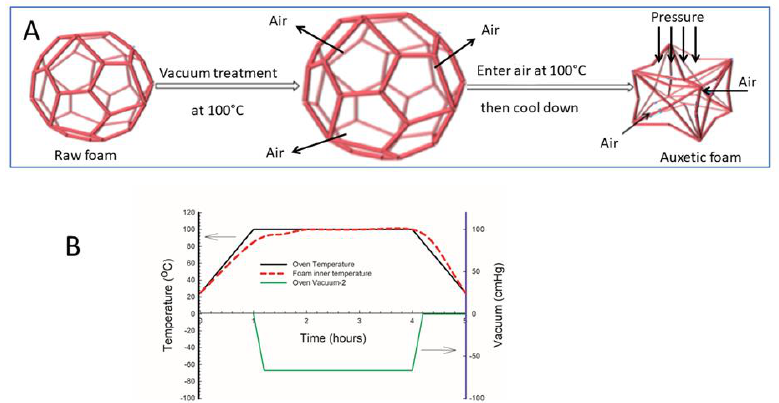
Figure 1. ( A ) Schematic representation of the mechanism generating a re-entrant structure from a polygonal morphology via vacuum combined with mechanical compression (VMC) and ( B ) the temperature profile imposed.